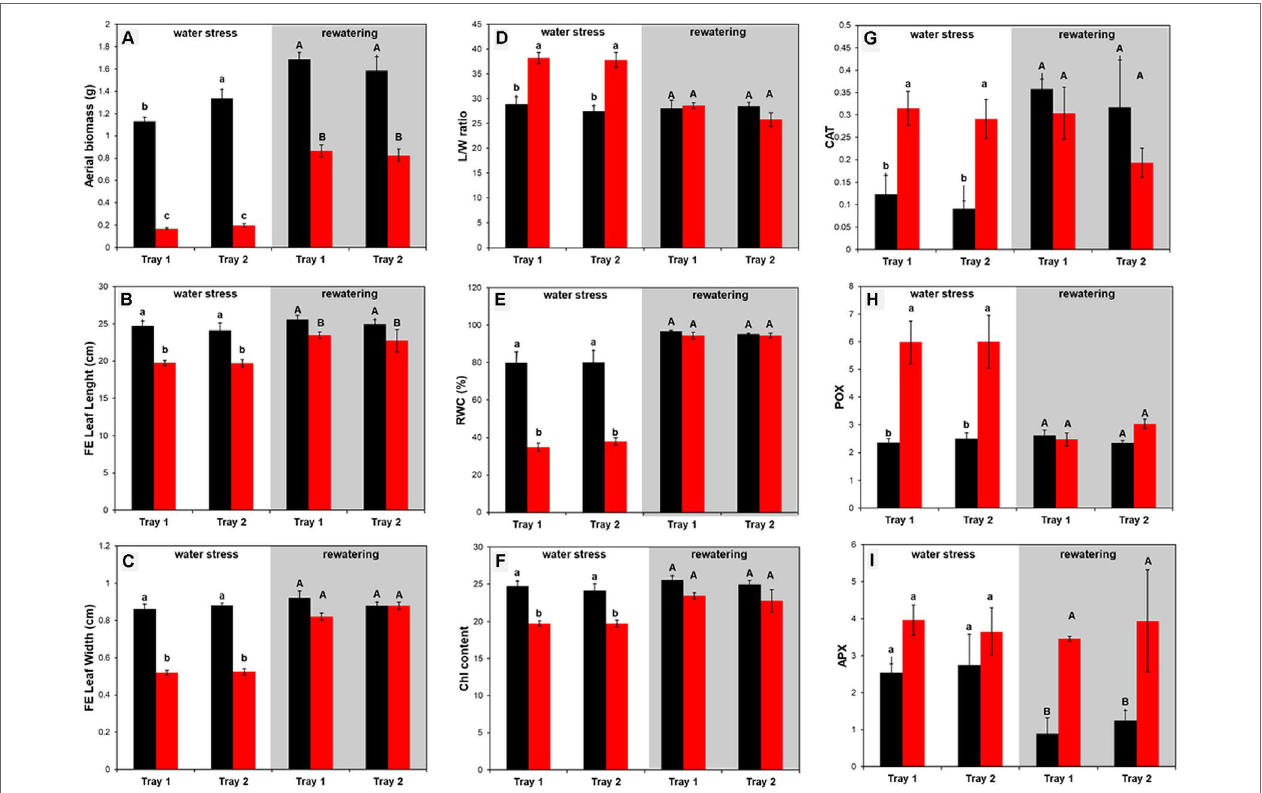
FIGURE 7 | Morphometric and physiological changes in barley ( Hordeum vulgare ) seedlings under water stress conditions and after subsequent rewatering. (A) Aerial biomass (FW, g), (B) leaf length (cm) and (C) width (cm) of the last fully expanded (FE) leaf, (D) the ratio between length and width, (E) the relative water content (%), (F) the index of the chlorophyll content, and the activity of the antioxidative enzymes (G) guaiacol peroxidase (POX, μmol s –1 mg –1 protein), (H) catalase (CAT, mmol